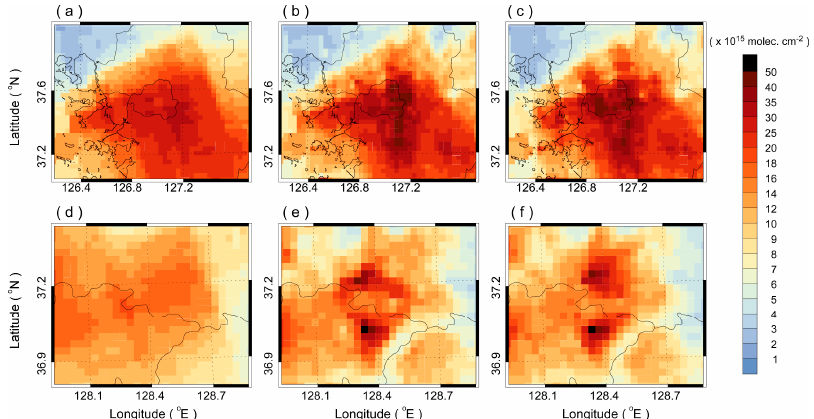
Figure 7. The spatial distributions of the re-gridded and the reconstructed OMI NO 2 VCD over (a-c) Seoul metropolitan area and (d-f) an area with industrial complexes. ( a and d ) re-gridded KNMI OMI NO 2 VCD, ( b and e ) reconstructed OMI NO 2 VCD using the WRF-Chem, ( c and f ) reconstructed OMI NO 2 VCD using the WRF/CMAQ.